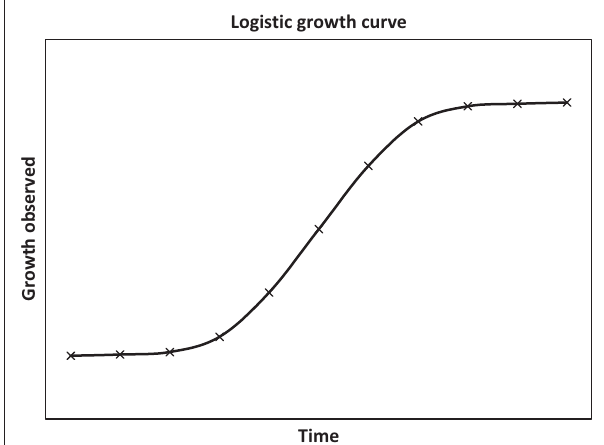
FIGURE 5: Logistic growth curve representing growth observed in malignant tumours.